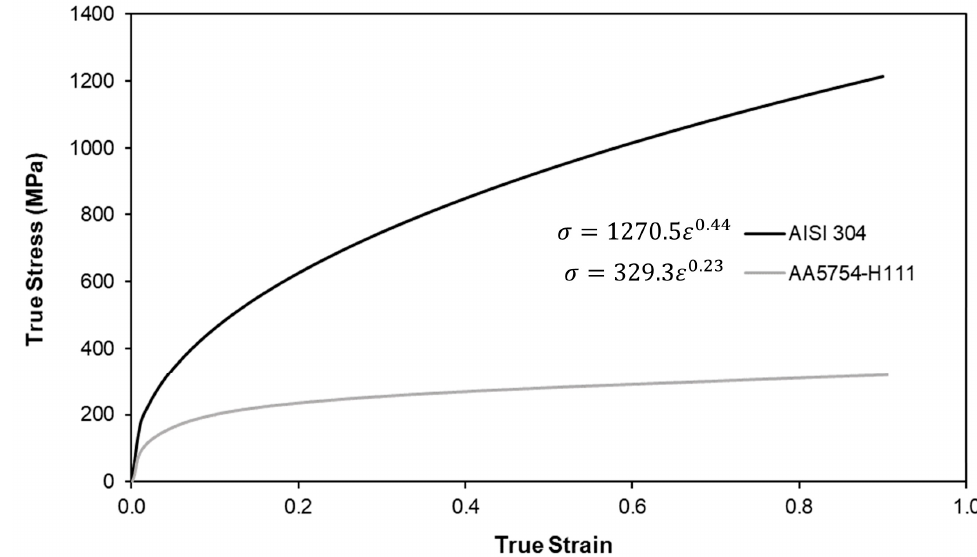
Figure 2. Flow curves of the AISI 304 stainless steel rivets and of the AA5754-H111 aluminium sheets. Each respective Ludwik–Holomon equation is also presented.